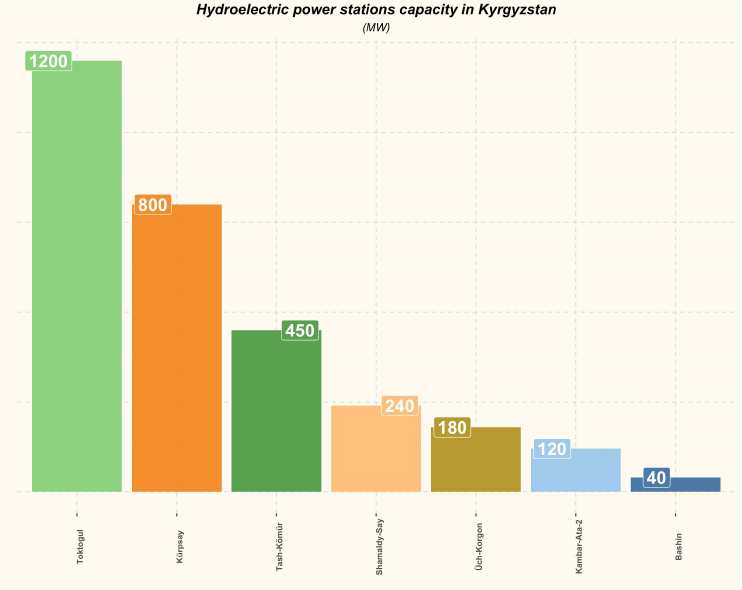
Figure 11. Hydroelectric power stations in Kyrgyzstan and their capacity. Data source: Elektricheskie Stantsii company website, http://www.energo-es.kg, accessed on 16 July